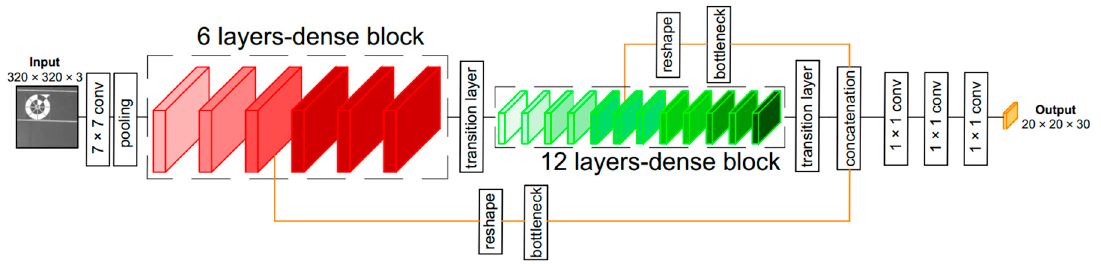
Figure 5. Proposed lightDenseNet architecture with two dense blocks and two lateral connections.